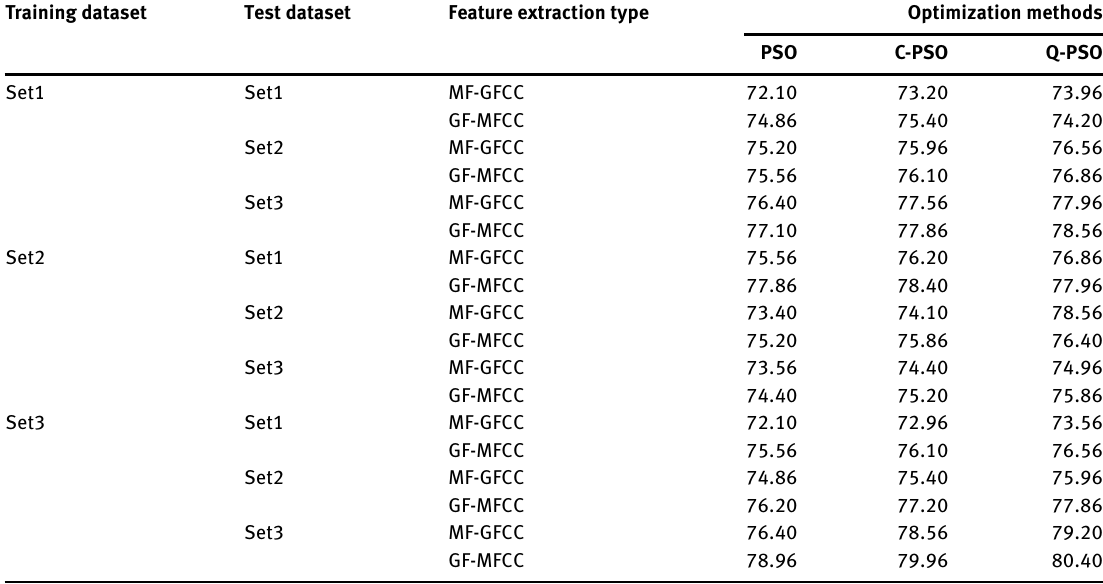
Table 3: WRr (%) Using Refined and Integrated Feature Vectors. Training